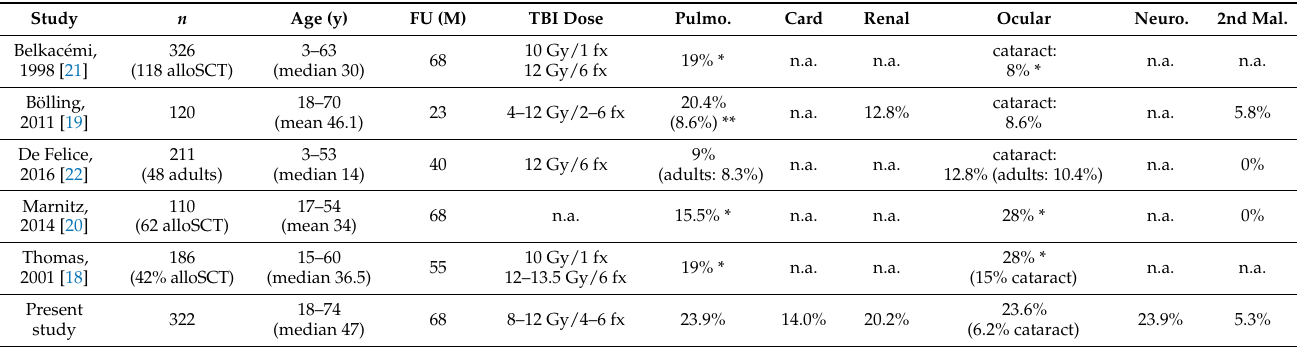
Table 4. Overview of patient cohorts undergoing TBI with a long-term follow-up. Analyses were only included if toxicities of 2 or more organs were reported. Studies with selective approaches based on IMRT were not included. 2nd mal.: secondary malignancies; card.: cardiac; FU: follow-up; fx: fraction; Gy: Gray; M: months; n.a.: data not provided; neuro.: neurological; pulmo.: pulmonary; TBI: total body irradiation; y: